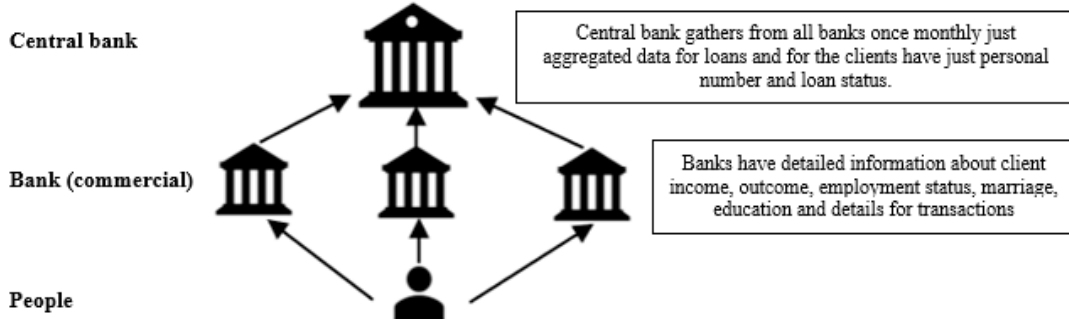
Figure 2. Credit information workflow and architecture. This figure illustrates that commercial banks have more details for the clients. The figure also illustrates that the central bank gathers aggregated data from all the commercial banks in a regular interval.